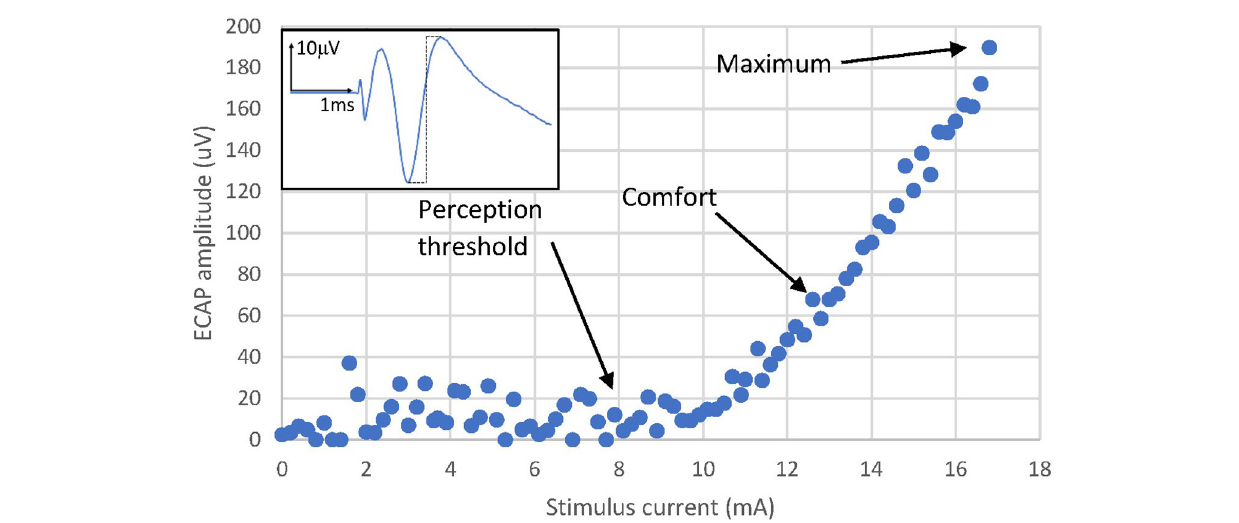
FIGURE 1 | Activation plot example from Patient 13. The amplitude of the ECAP is calculated as the peak-to-peak amplitude of the first negative lobe and second positive lobe of the ECAP (dashed black line of the example ECAP shown in the figure inset). The ECAP amplitude increases linearly with stimulus current after reaching an activation threshold. Likewise, the sensation perceived also increases in strength from a threshold which normally is close to the activation threshold. Note that perception thresholds and ECAP thresholds can differ to a relatively small degree. Noise and the ability to record single fibre action potentials reliably is one factor, a potential psychophysical element cannot be ruled out. Sensation threshold was reached at 7.8 mA, a comfortable stimulation level was reached at 12.8 mA and the stimulus sensation was deemed maximal (starting to be uncomfortably strong) at 17 mA. Note that the threshold and slope of the activation plot for a particular patient with a fixed stimulating configuration varies with posture and other physiological changes (Parker et al., 2012, 2013; Mekhail et al., 2019; Russo et al., 2020).